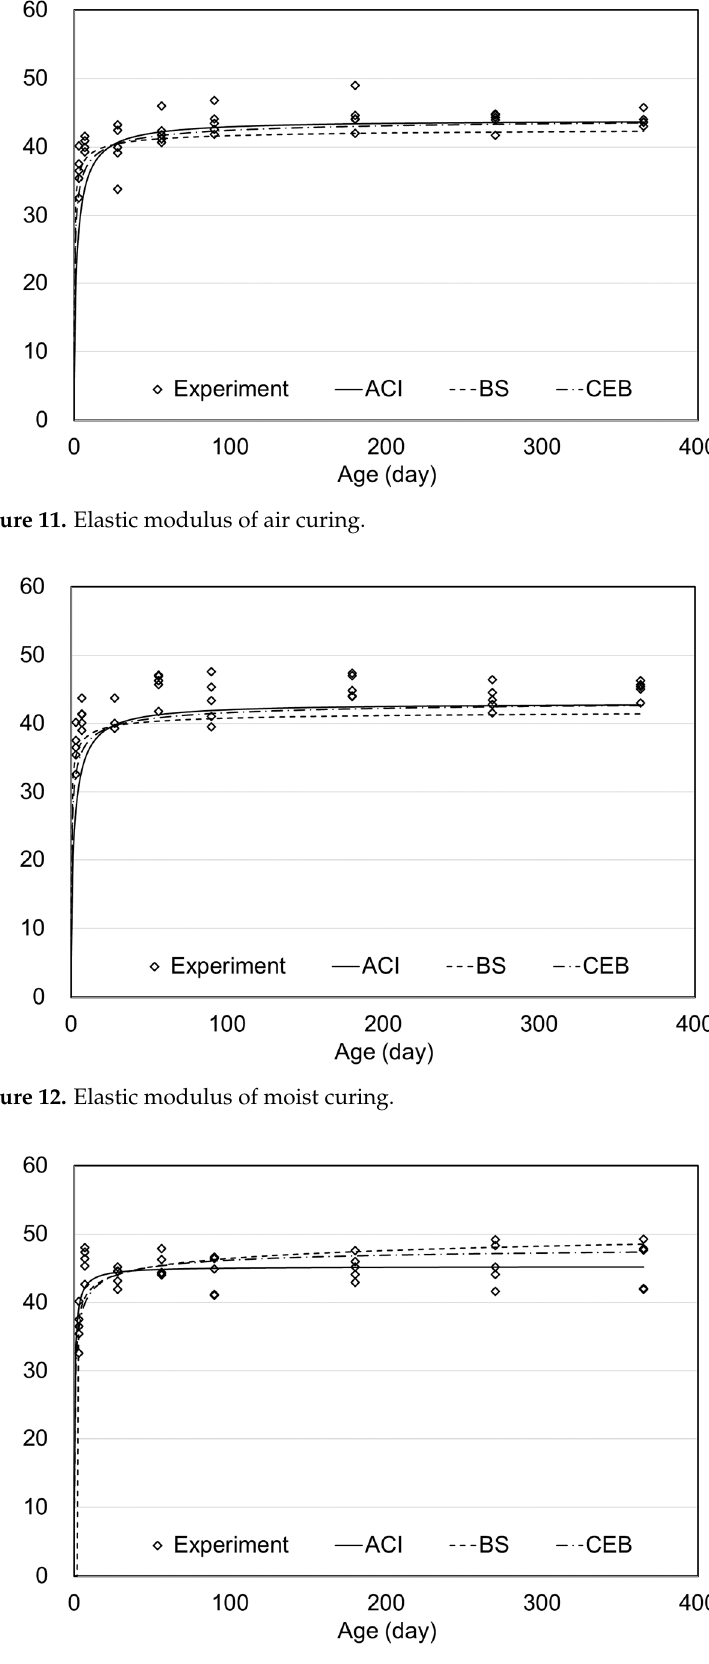
Figure 13. Elastic modulus of steam curing.